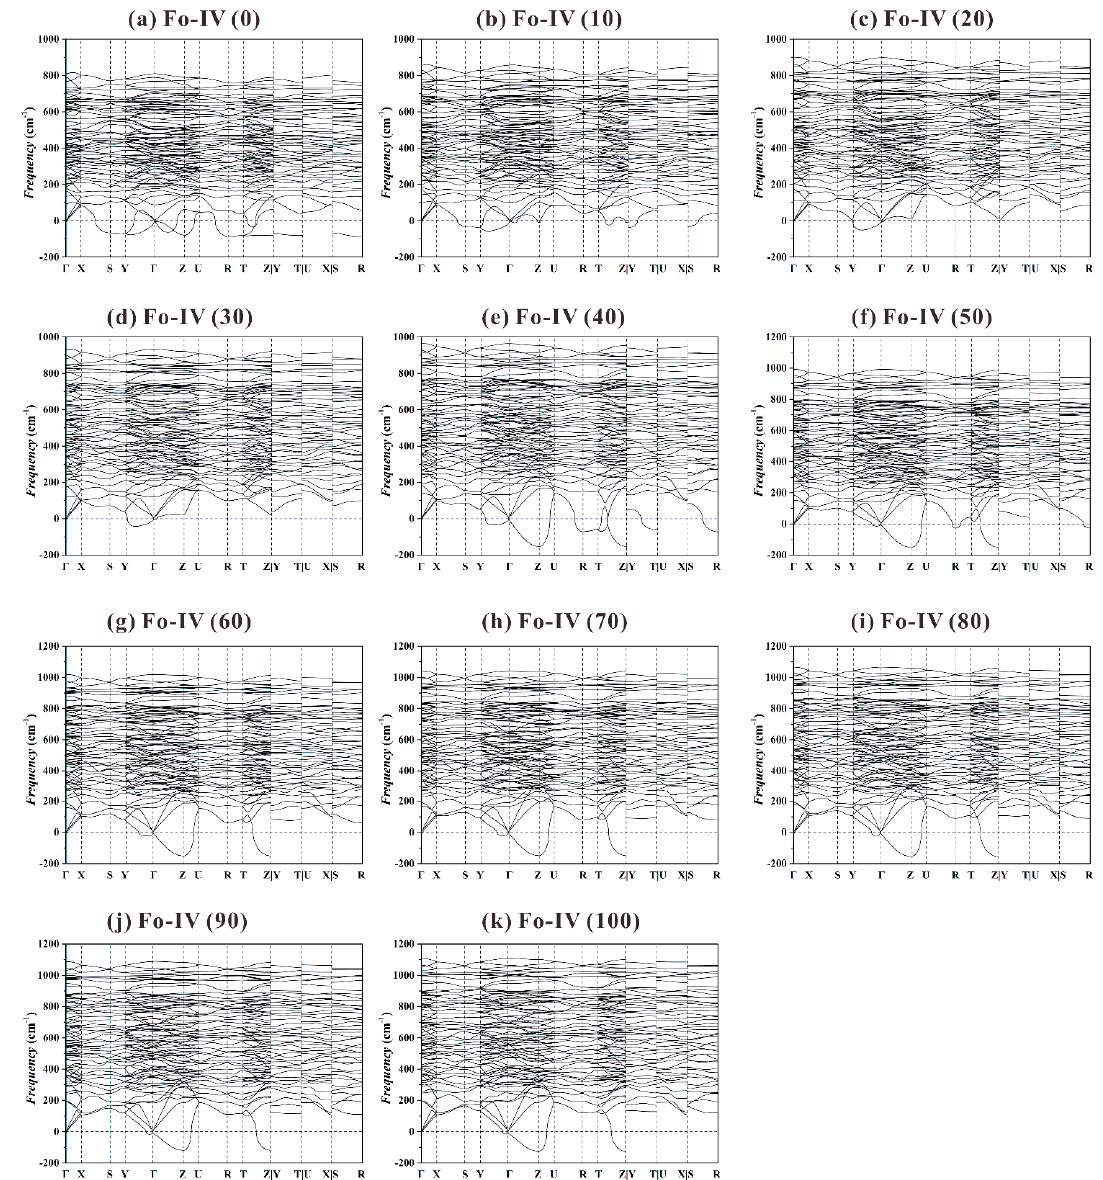
Figure 11. Calculated phonon dispersion curves for Fo-IV from 0 to 100 GPa with a k -path